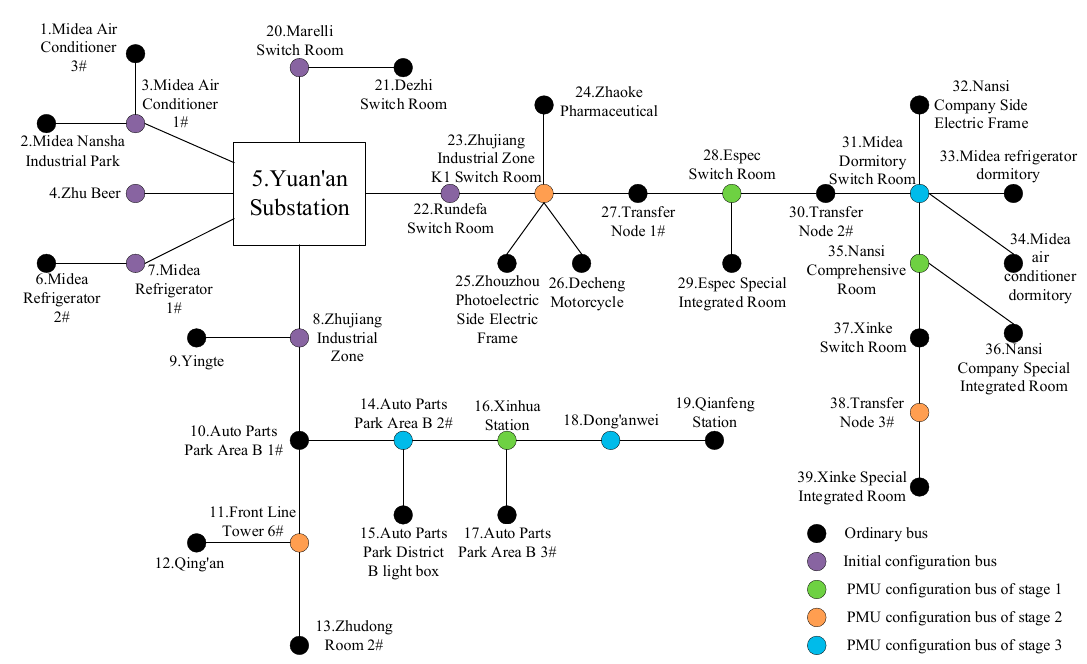
Figure 15. D-PMU placement topology of the Yuan’an substation.